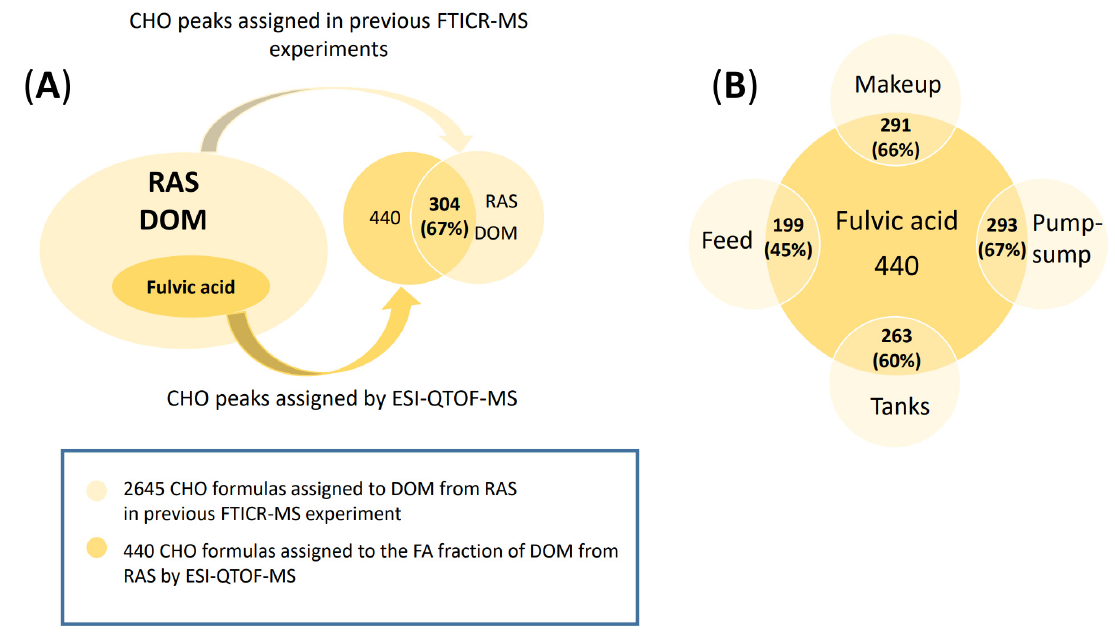
Figure 7. Venn diagrams comparing the number of CHO peaks assigned to the fulvic acid fraction of DOM by ESI-QTOF-MS and 2645 assigned to DOM from RAS by FTICR-MS in previous experiments under negative mode [4]. The DOM samples of the previous experiment were isolated from the makeup, pump-sump, tank, and feed samples during the production of Atlantic salmon ( Salmo salar ) post-smolts at the Nofima Centre for Recirculation in Aquaculture (NCRA) in Sunndalsøra, Norway. The set-up of the RAS used in the previous experiment can be found in Aguilar-Alarc ó n et al., 2022 [4]. The Venn diagrams were represented with: ( A ) The total number of CHO peaks in the recirculating aquaculture fulvic acids (RASFA) sample and those found common with DOM from RAS. ( B ) The total number of CHO peaks identified in the RASFA sample and those found common with the makeup, pump-sump, tank and feed samples of DOM from RAS analyzed by 7T FTICR-MS